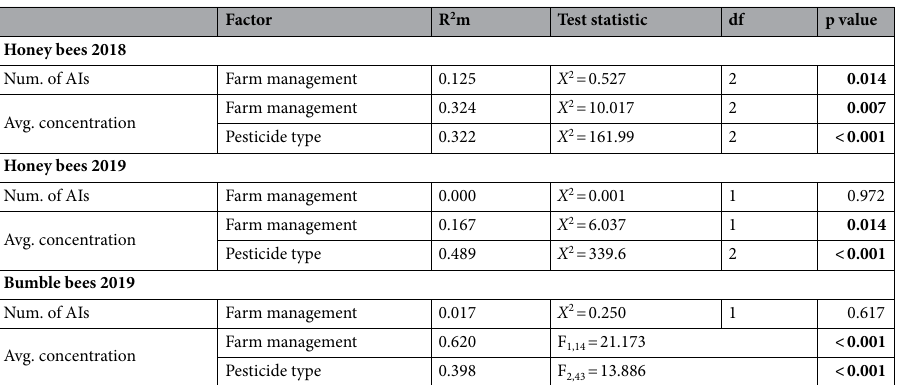
Table 2. Statistical results from generalized linear mixed effects models (Poisson distribution) used to test the effect of farm management on number of active ingredients (AIs) detected bee collected pollen, and results from linear mixed models used to test the effects of farm management on pesticide concentrations in pollen, as well as differences in pesticide types (fungicides, insecticides, herbicides) found in the pollen.